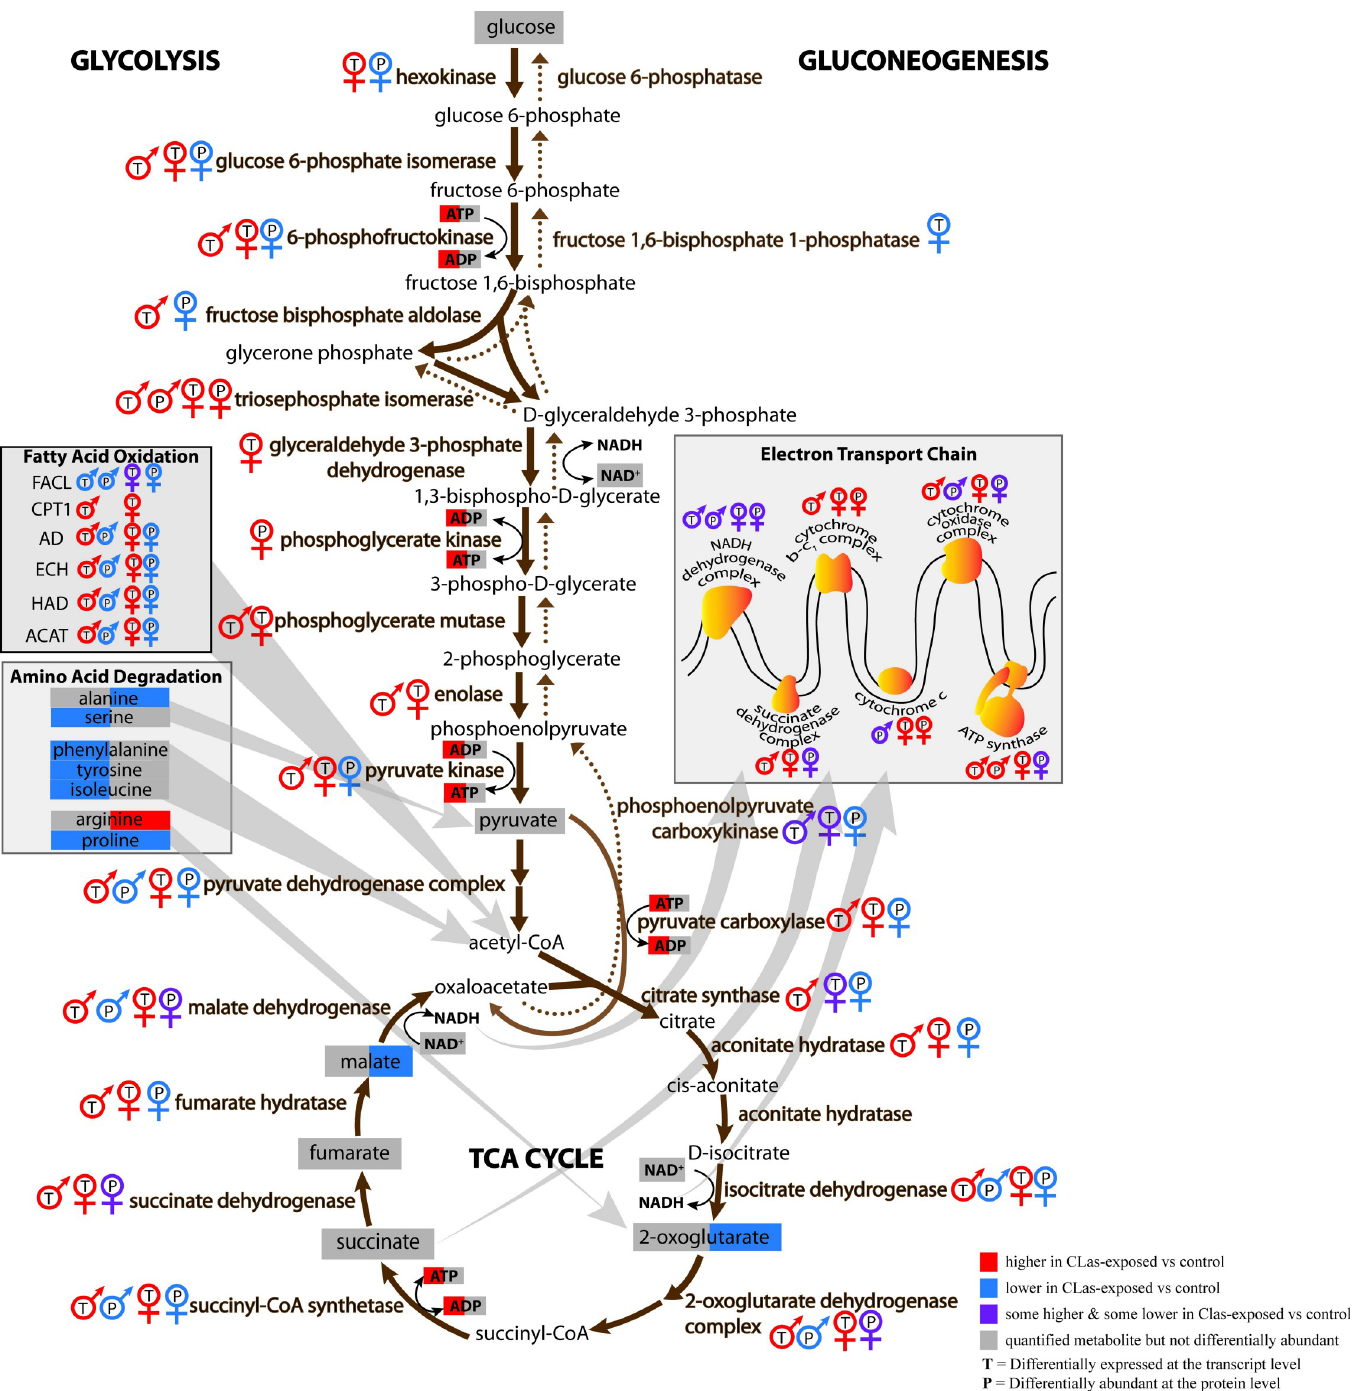
Fig 9. Pathway diagram of DEGs, DAPs and DAMs involved in glycolysis, gluconeogenesis, pyruvate decarboxylation, the TCA cycle, fatty acid oxidation, and the electron transport chain. DEGs (represented with a ‘T’), or DAPs (represented with a ‘P’) for males are depicted with the male sex symbol while those for females are depicted with the female sex symbol. Metabolites are highlighted in the left half if they were measured/differentially abundant in males, and are highlighted in the right half if they were measured/differentially abundant in females. Up-regulated DEGs/DAPs/DAMs are in red, down-regulated DEGs/DAPs/DAMs are in blue, measured but non-DAMs are highlighted in gray, and if some subunits or genes/proteins for the same enzyme are up-regulated and down-regulated then they are depicted in purple.